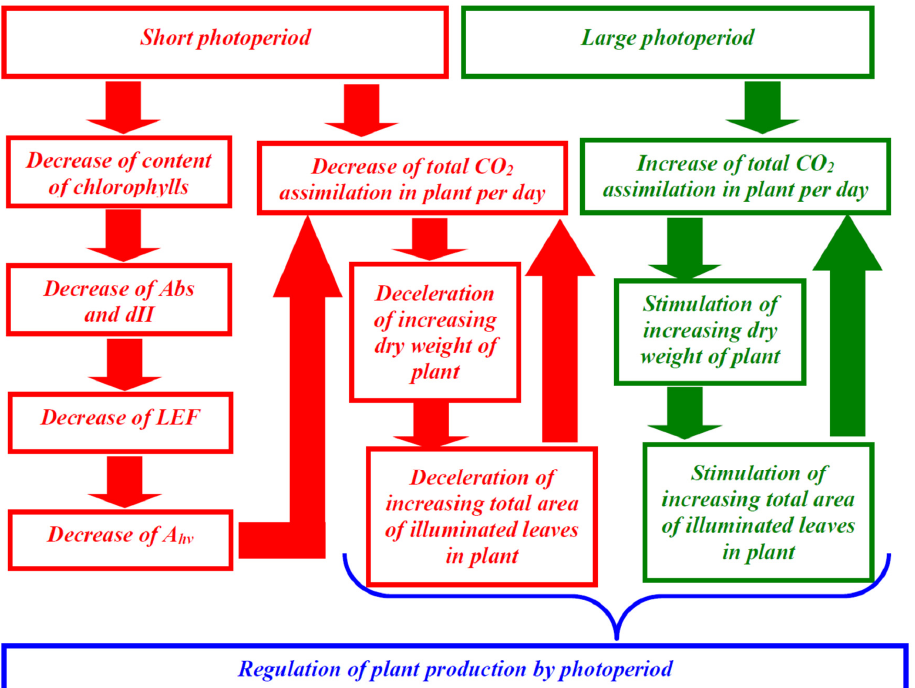
Figure 10. Potential ways of photoperiod influence on production in lettuce. The long photoperiod increases the total CO 2 assimilation in the plant and thereby stimulates increased dry weight and the total area of illuminated leaves in the plant. This increasing additionally stimulates the total CO 2 assimilation forming a positive feedback loop. In contrast, the short photoperiod decreases the total CO 2 assimilation in the plant because the duration of photosynthetic activity is decreased, and duration of the dark respiration is not changed. This effect decelerates the increase in the dry weight and the total area of illuminated leaves in the plant. Additionally, this short photoperiod decreases the content of chlorophylls; this effect decreases Abs and dII and, thereby, suppresses the linear electron flow and CO 2 assimilation.